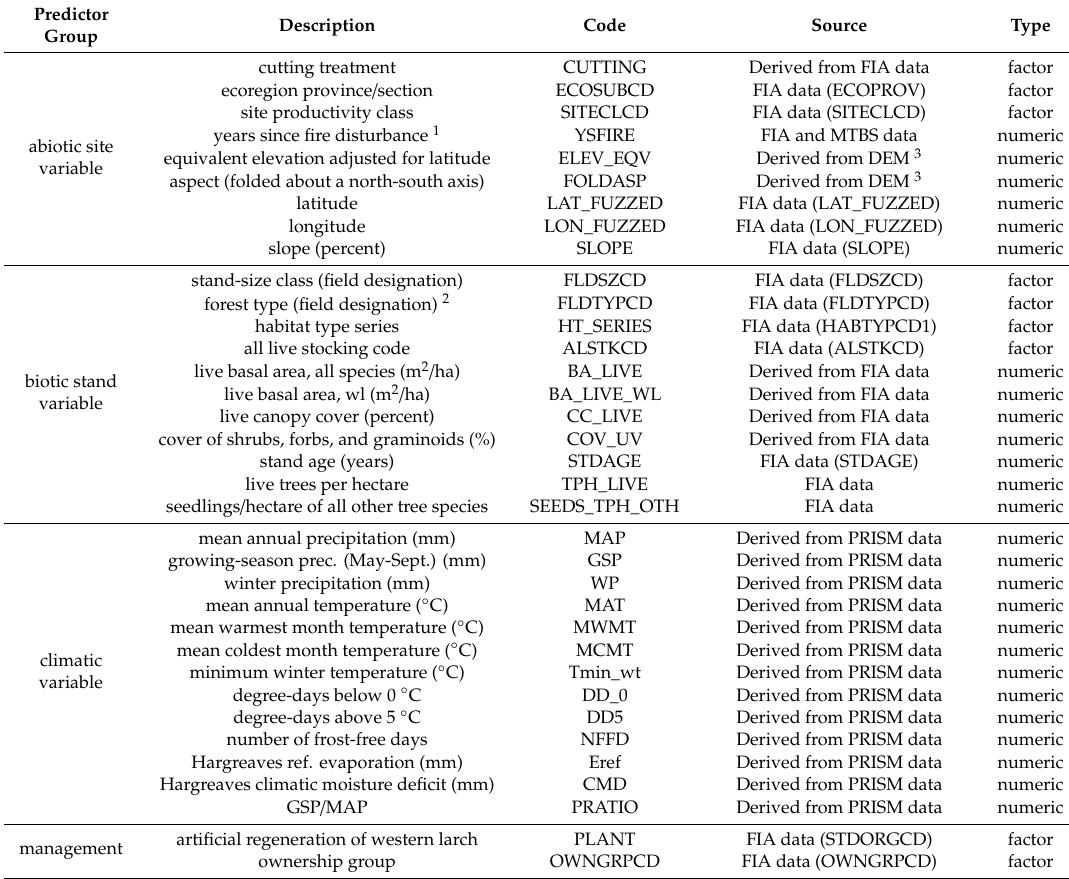
Table 1. Predictor variables evaluated for inclusion in western larch seedling presence models, by descriptive